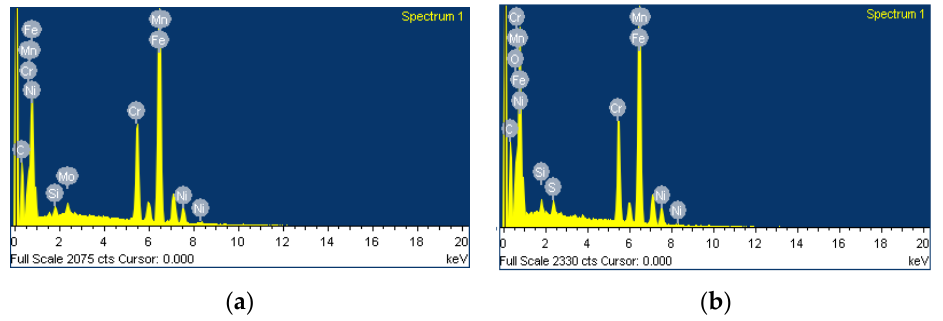
Figure 14. EDS/SEM spectrum analysis of fracture face of ATIG welded zone ( a ) and TIG welded